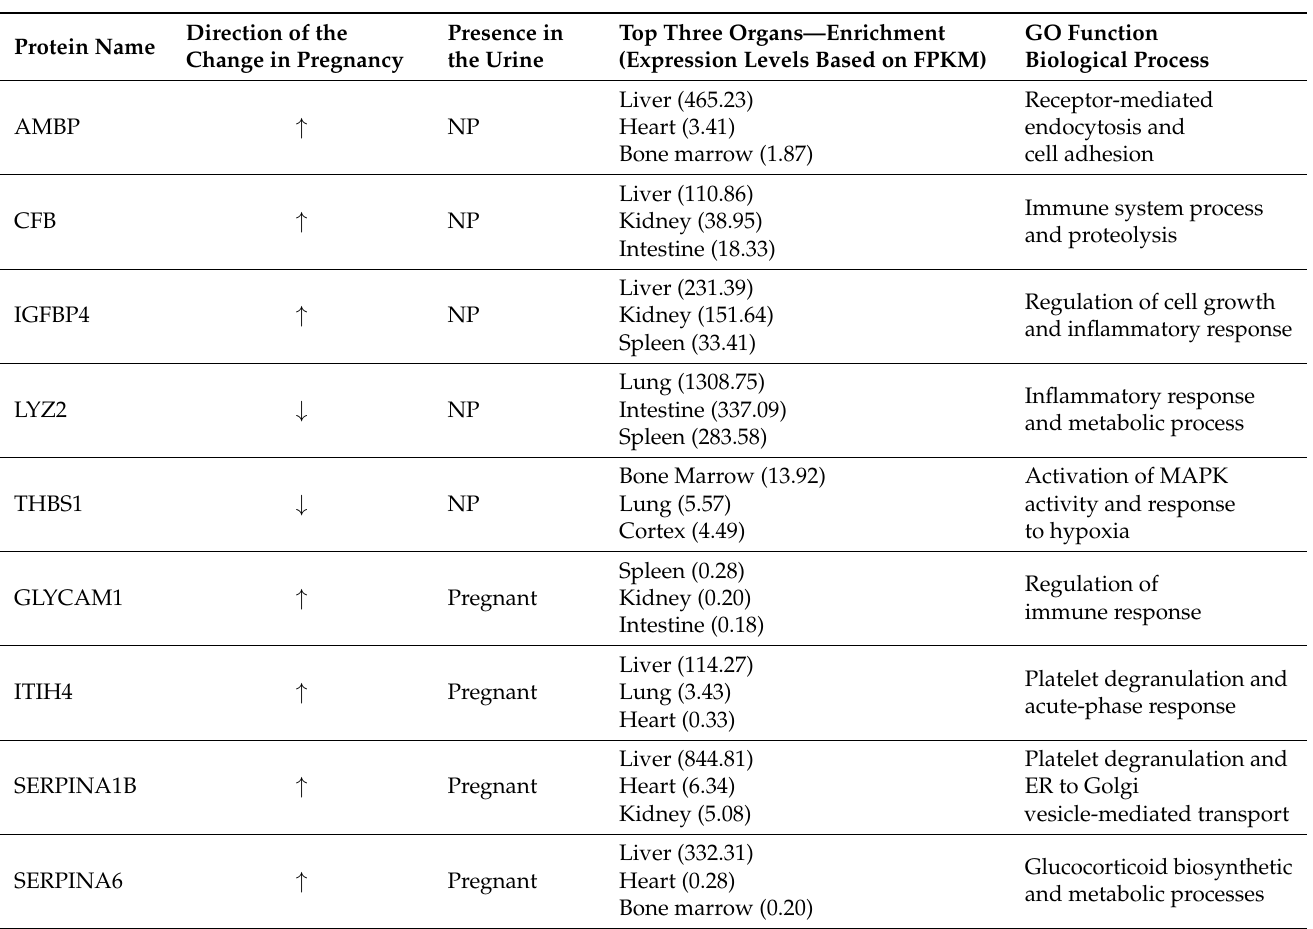
Table 1. Tissue enrichment and function of the nine proteins altered in both urine and plasma in response to pregnancy. Analysis was performed with TissueEnrich (https://tissueenrich.gdcb. iastate.edu/) and UniProt